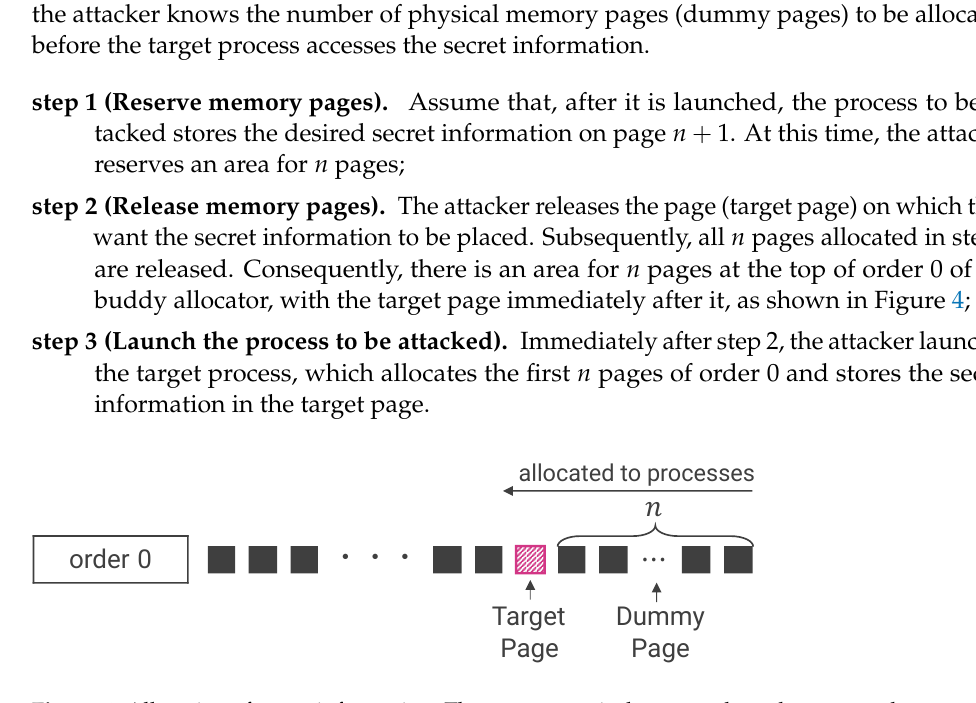
Figure 4. Allocation of secret information. The target page is the page where the secret to be recovered by RAMBleed is to be stored, and the dummy pages are pages reserved for data to be accessed by the attack target before the secret. When the attack begins, the buddy allocator assigns the dummy pages to the attack target first. The secret is then assigned to the target